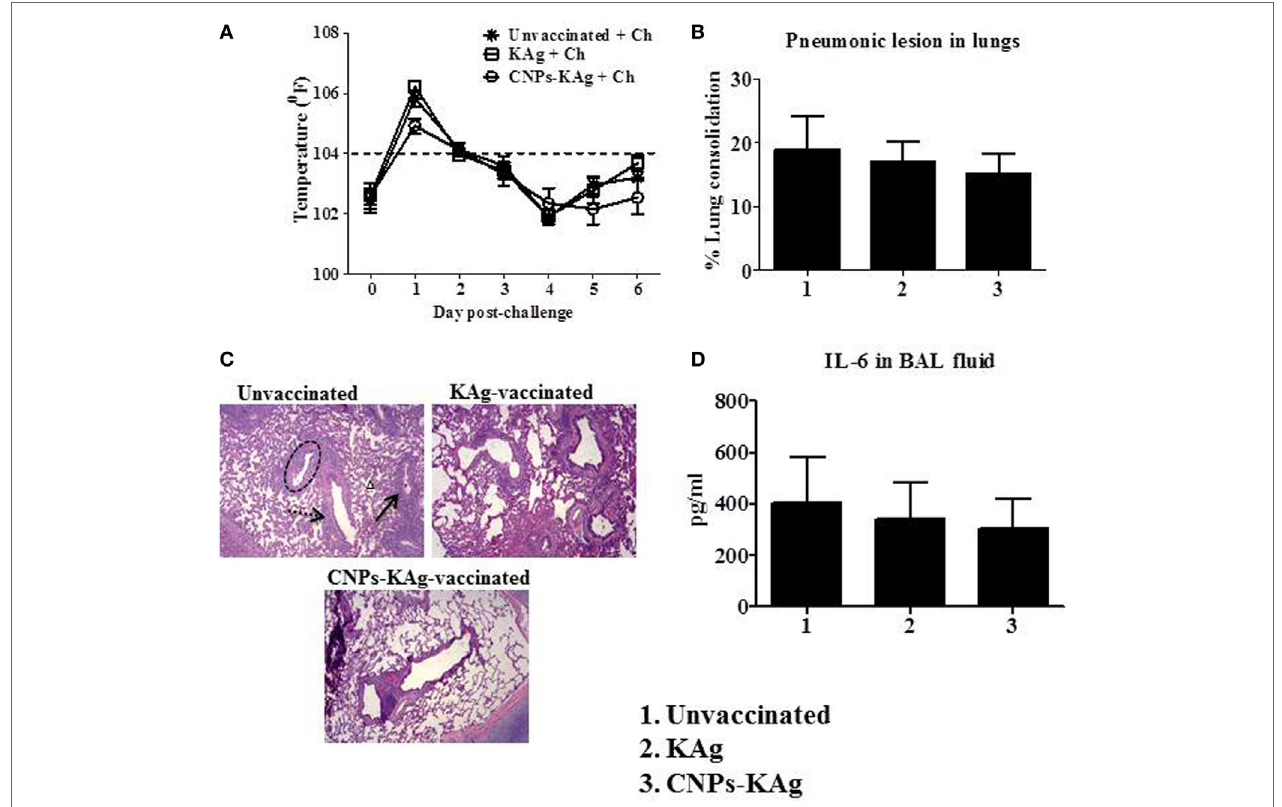
FigUre 8 | Clinical and pathological changes in pigs vaccinated with chitosan nanoparticles (CNPs)-KAg post-challenge. (a) Rectal temperature was recorded daily after challenge until the day of necropsy. (B) Gross pneumonic lesions in lungs determined at day post-challenge (DPC) 6. (c) Representative Hematoxylin and eosin (H&E)-stained lung pictures showing bronchial exudates (dotted black circle), perivascular inflammation (black arrow), peribronchial inflammation (dashed black arrow), and interstitial pneumonia (small black triangle). (D) Secretion of cytokine interleukin (IL-6) in bronchoalveolar lavage (BAL) fluid. Data represent the mean value of three to five pigs ±